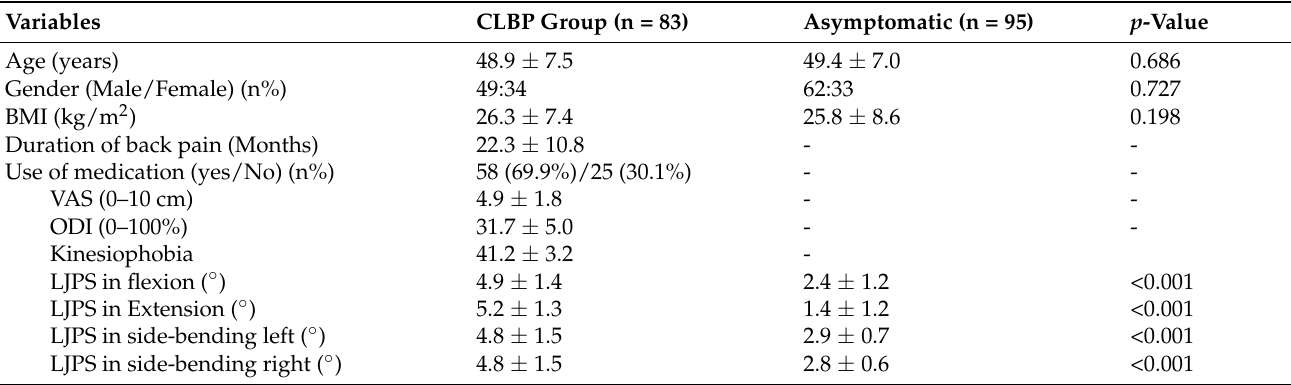
Table 1. Physical and demographic characteristics of